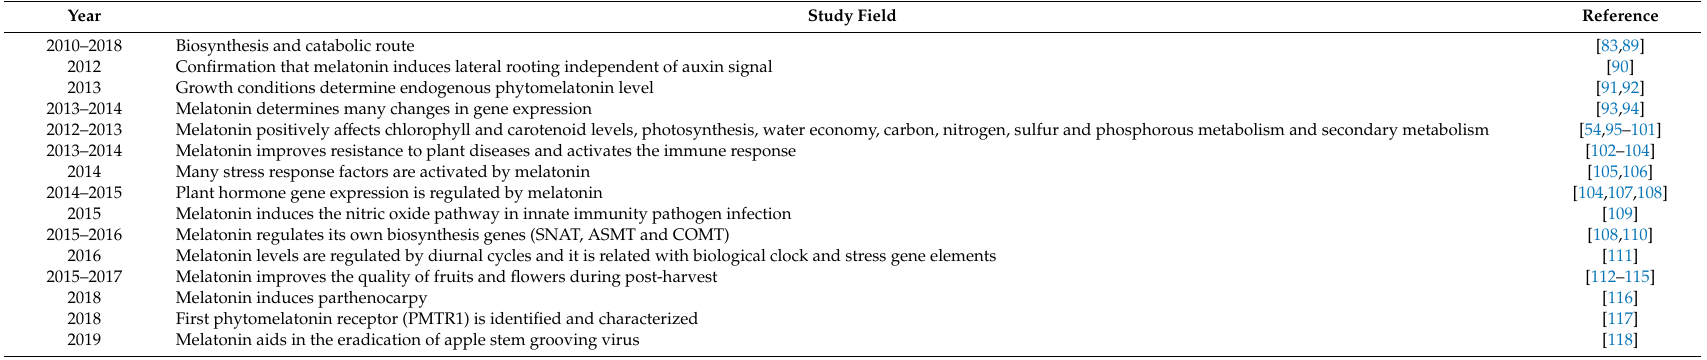
Table 2. Pioneering studies on melatonin in plants in the period